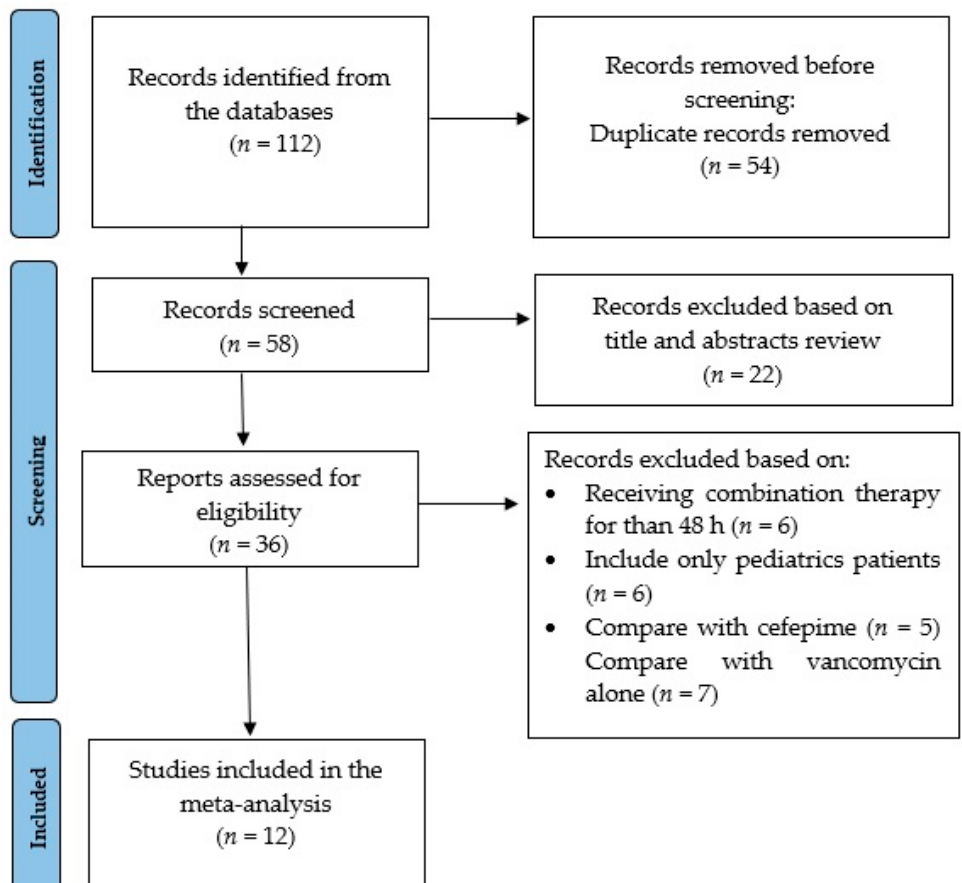
Figure 1. Flow diagram for selection of studies included in the